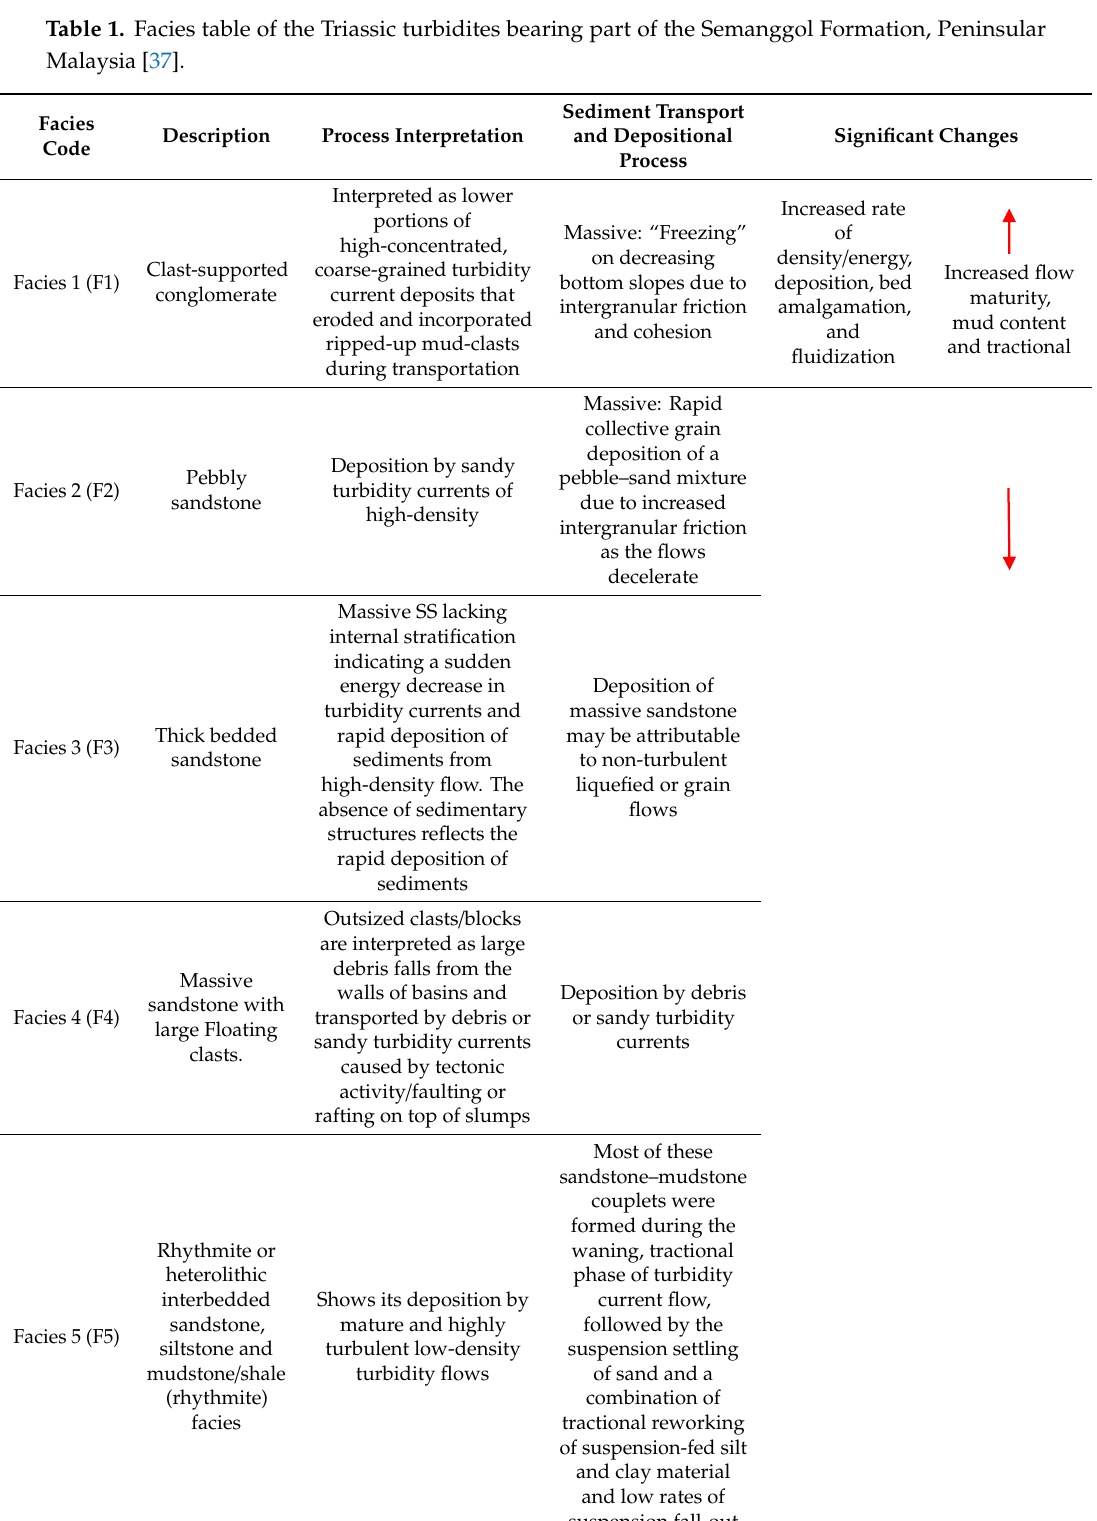
Table 1. Facies table of the Triassic turbidites bearing part of the Semanggol Formation, Peninsular Malaysia [37].